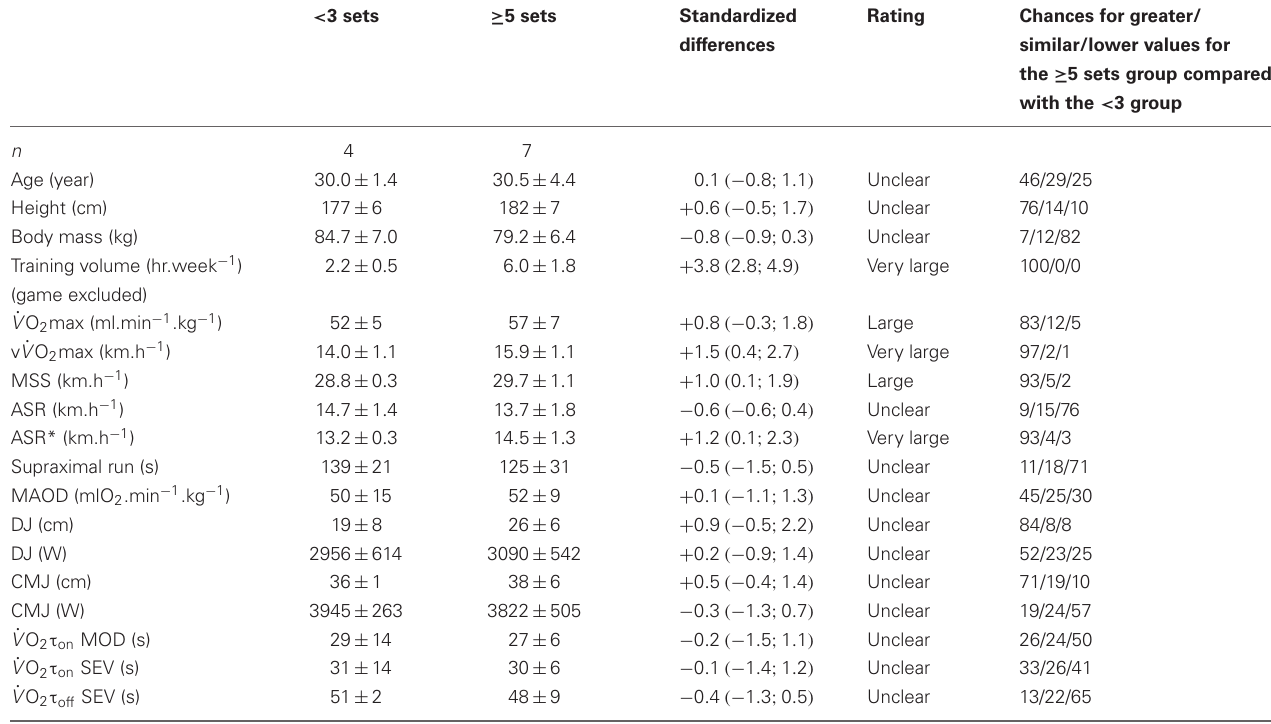
Table 1 | Anthropometric, physiological and performance characteristics for the team sport players with respect to the number of HIT sets completed before